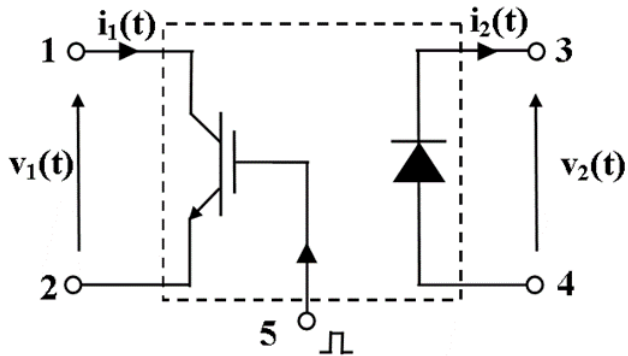
Figure 2. Diagram of a diode–transistor switch with the IGBT and the diode. The network representation of the considered electrothermal averaged model of a diode–transistor switch (AVG model) is shown in Figure 3. This switch contains an IGBT and a